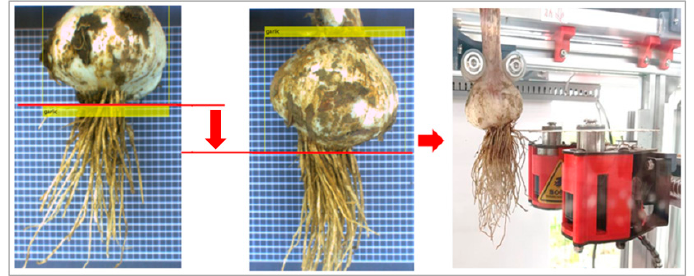
Figure 15. Schematic diagram of garlic root cutting controlled by IRM-YOLOv2 algorithm.